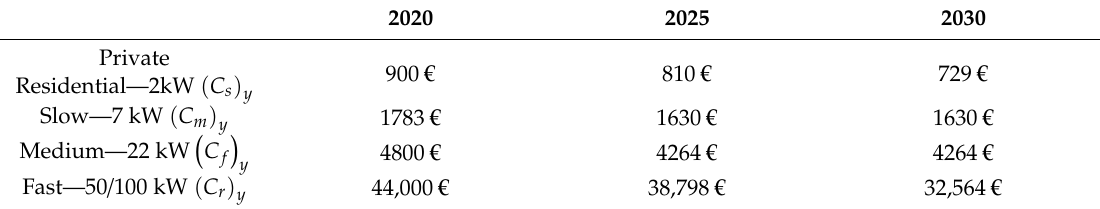
Table 9. Charging station (CS) costs forecast for the various power